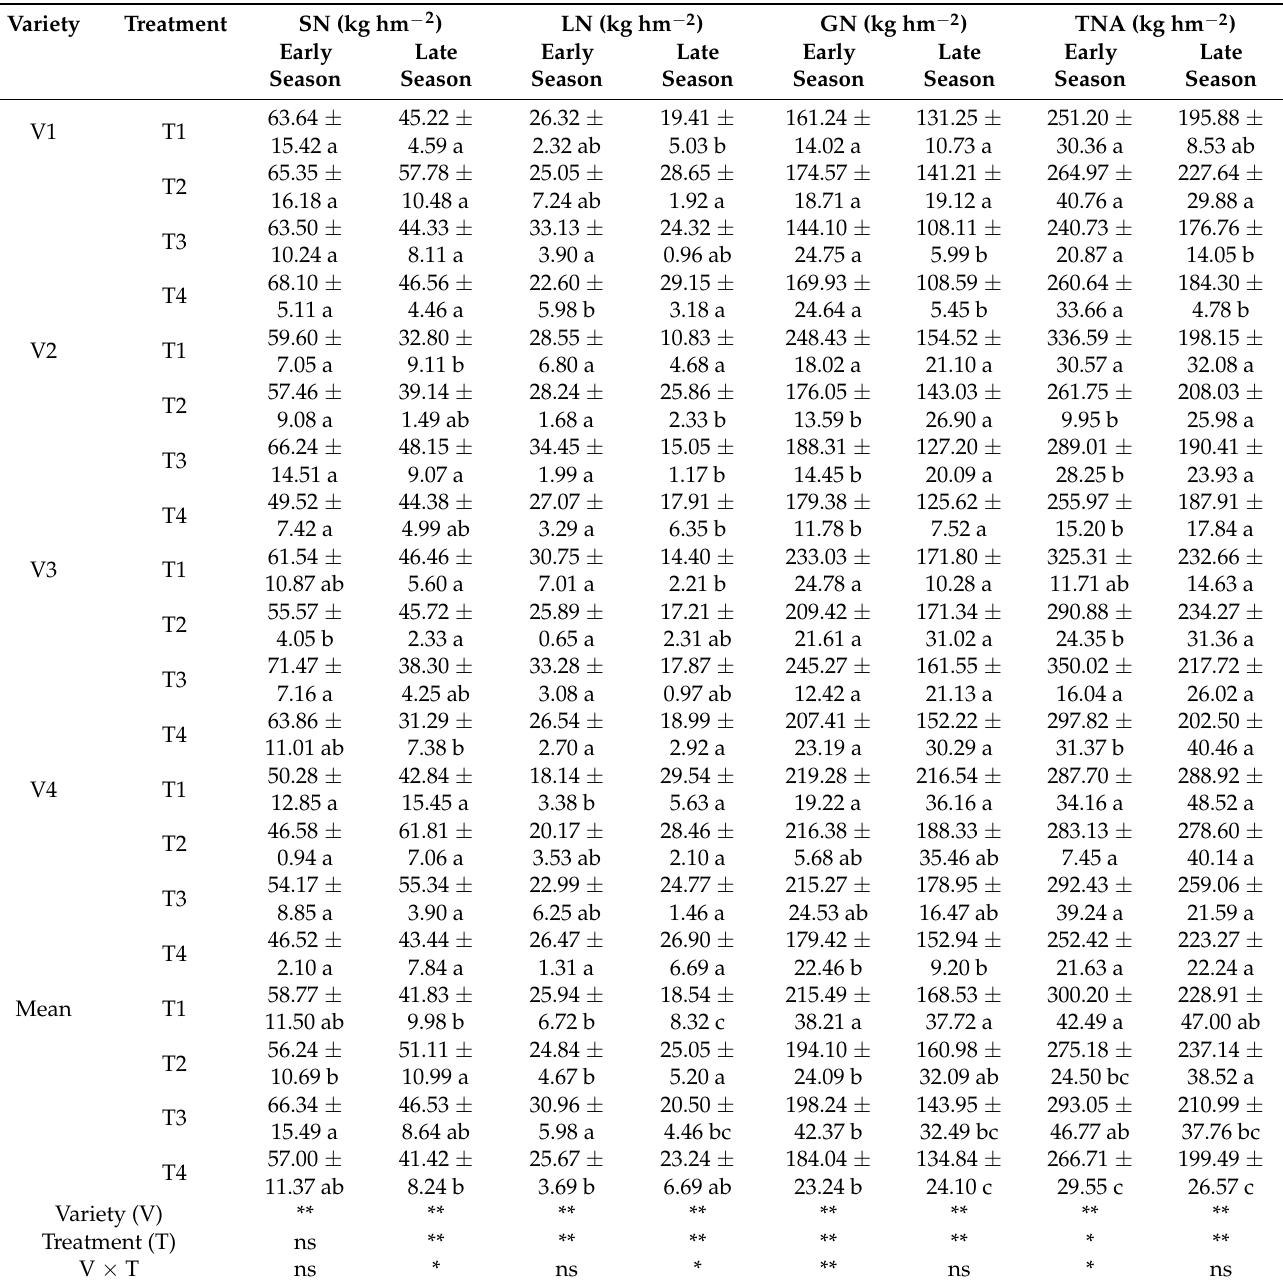
Table 7. Effects of different seedling numbers per hill and row spacing on nitrogen accumulation in aboveground organs of